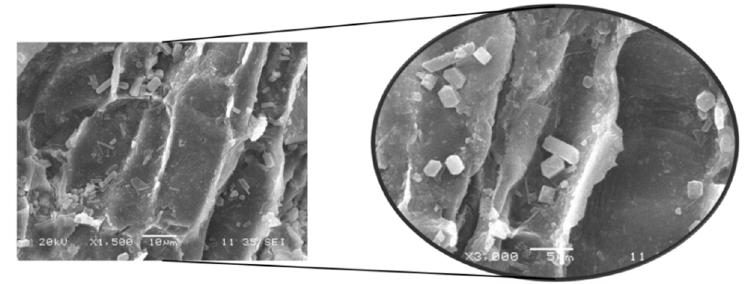
Figure 4. Content of salts, mainly sodium chloride and potassium chloride, in the macroalgae consortium.